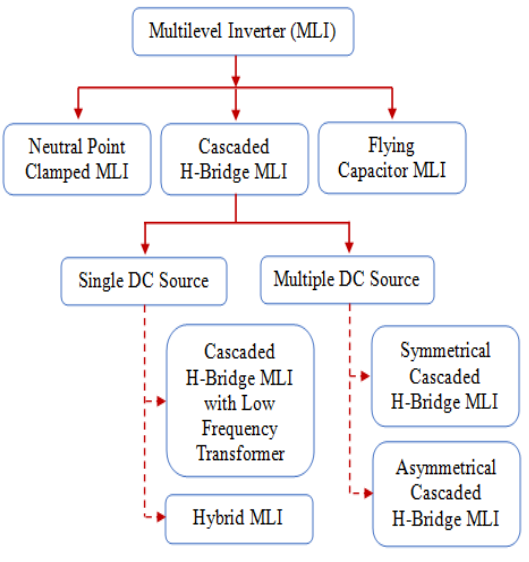
Figure 1. Arrangement of Multilevel Inverter (MLI)